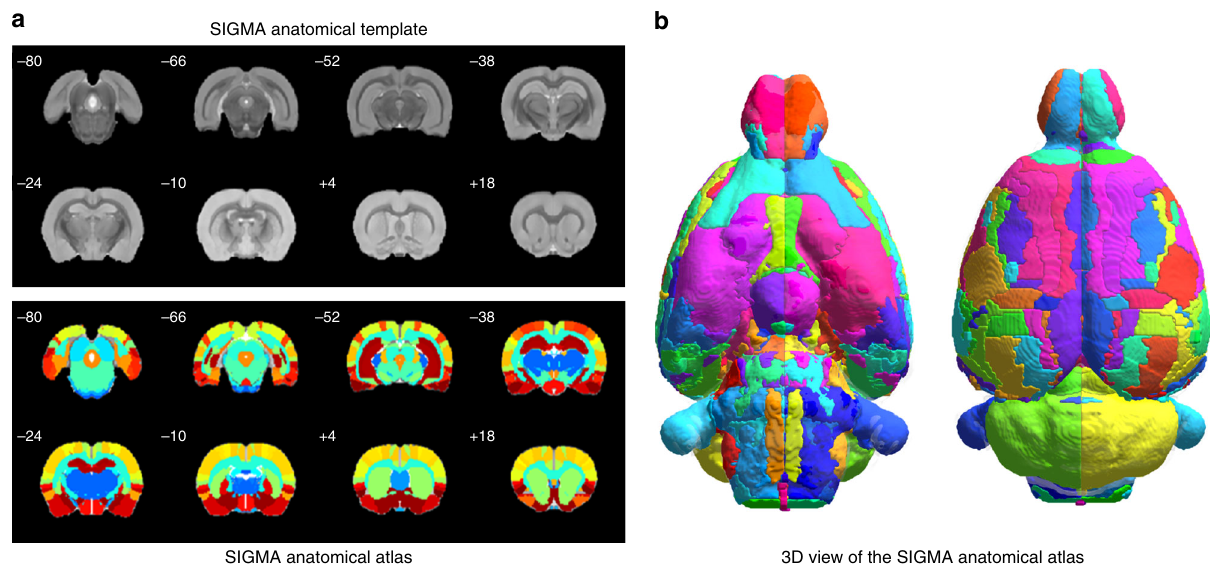
Fig. 4 The SIGMA anatomical template and atlas of rat brain. a Coronal slices of the ex vivo SIGMA anatomical template of the rat brain and the corresponding slices of the SIGMA anatomical atlas and ( b ) 3D representation of the SIGMA anatomical